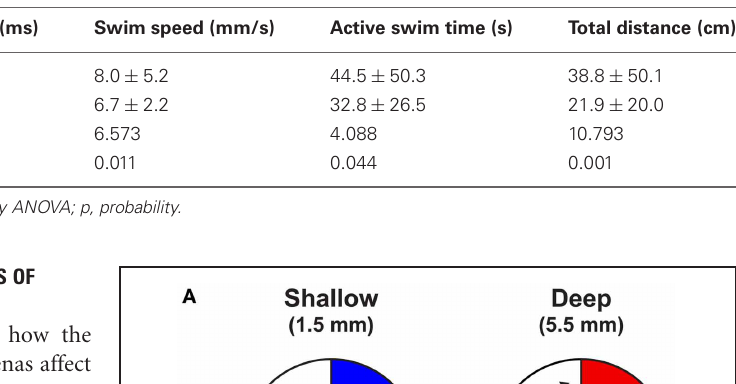
Table 1 | Comparison of the properties of locomotor activity for larvae at 4 and 7dpf.